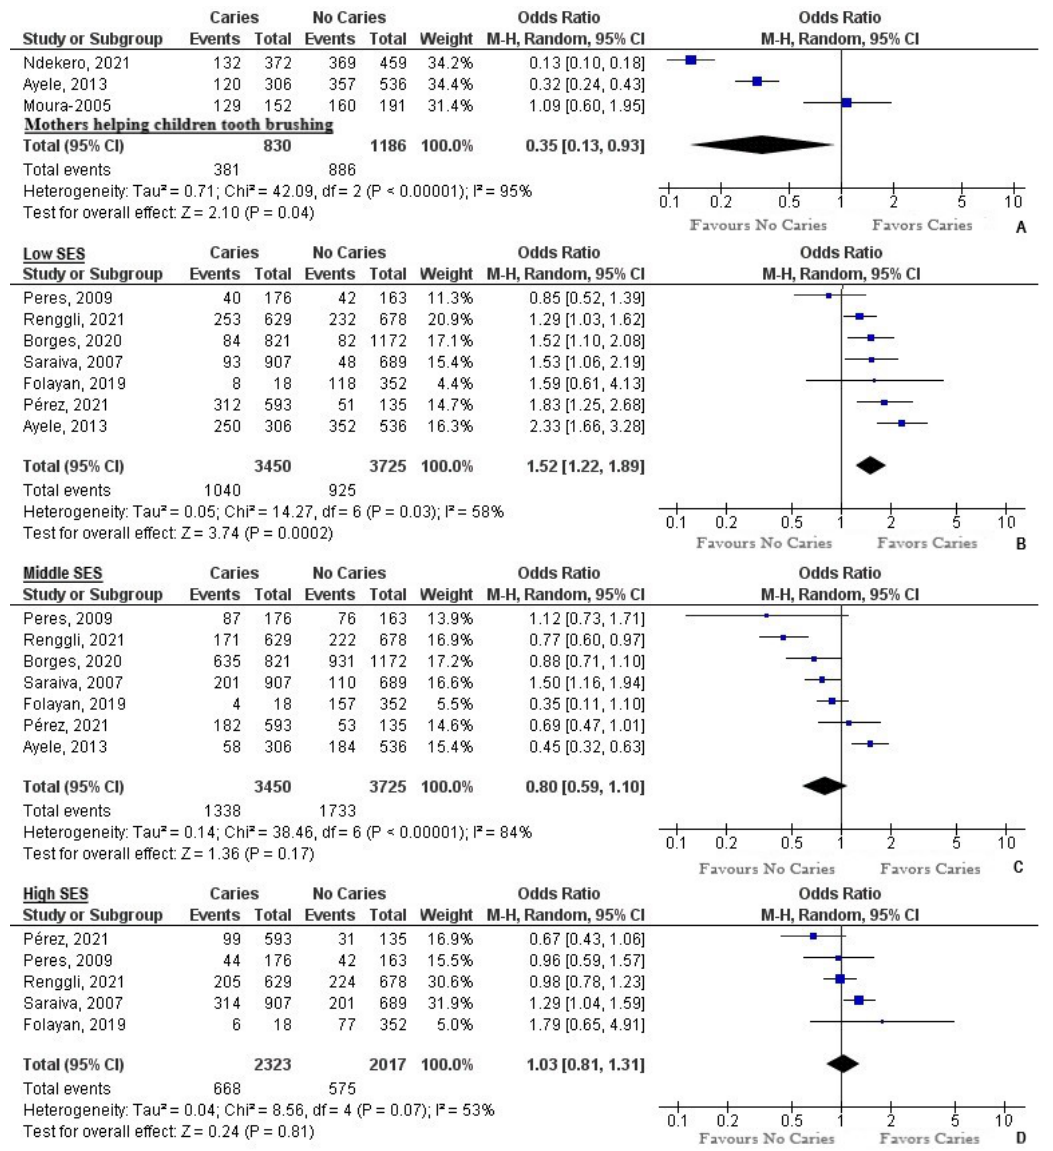
Figure 5. ( A ) Mothers helping children in tooth brushing: a forest plot depicting OR of children with caries compared to no caries. Heterogeneity: Tau 2 = 0.71; Chi 2 = 42.09, df = 2 ( p < 0.00001); I 2 = 95%. Test for overall effect: Z = 2.10 ( p = 0.04); A forest plot depicting OR of children with caries compared to no caries belonging to the following socioeconomic status: ( B ) Low socioeconomic status: Heterogeneity: Tau 2 = 0.05; Chi 2 = 14.27, df = 6 ( p = 0.03); I 2 = 58%. Test for overall effect: Z = 3.74 ( p = 0.0002) ( C ) Middle socioeconomic status: Heterogeneity: Tau 2 = 0.14; Chi 2 = 38.46, df = 6 ( p < 0.00001); I 2 = 84%. Test for overall effect: Z = 1.36 ( p = 0.17); ( D ) High socioeconomic status: Heterogeneity: Tau 2 = 0.04; Chi 2 = 8.56, df = 4 ( p = 0.07); I 2 = 53%. Test for overall effect: Z = 0.24 ( p = 0.81).